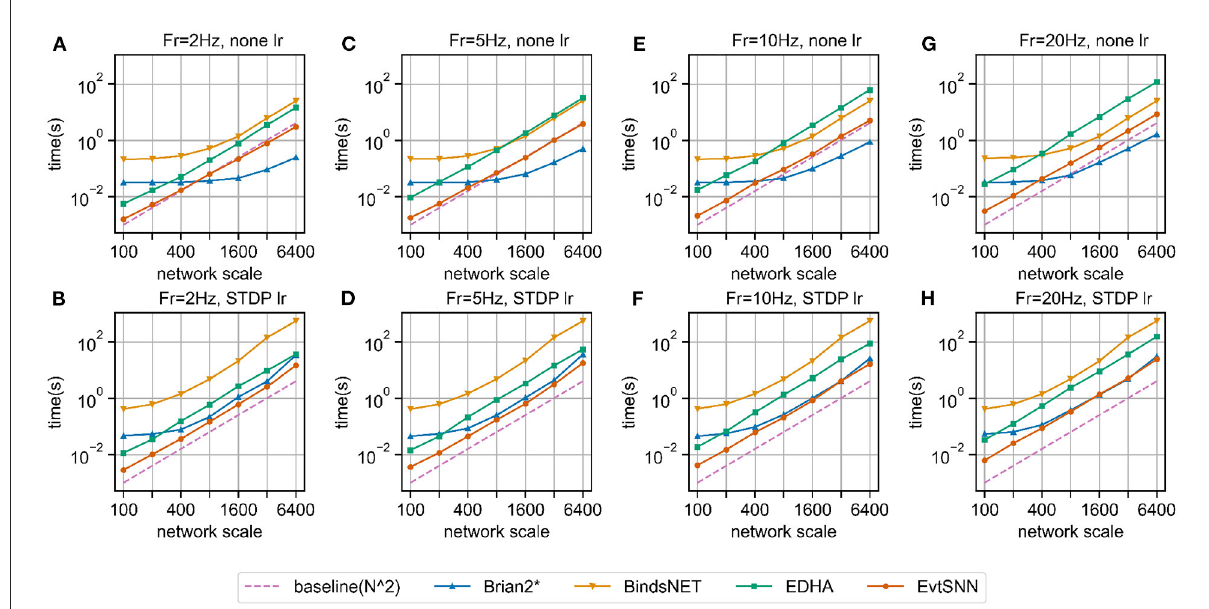
FIGURE5 Benchmark simulation results. (A–D) No learning rule, the firing frequency of input layer neurons is 2, 5, 10, and 20 Hz, respectively. (E–H) Using the STDP learning rule, the firing frequency is 2, 5, 10, and 20 Hz, respectively.